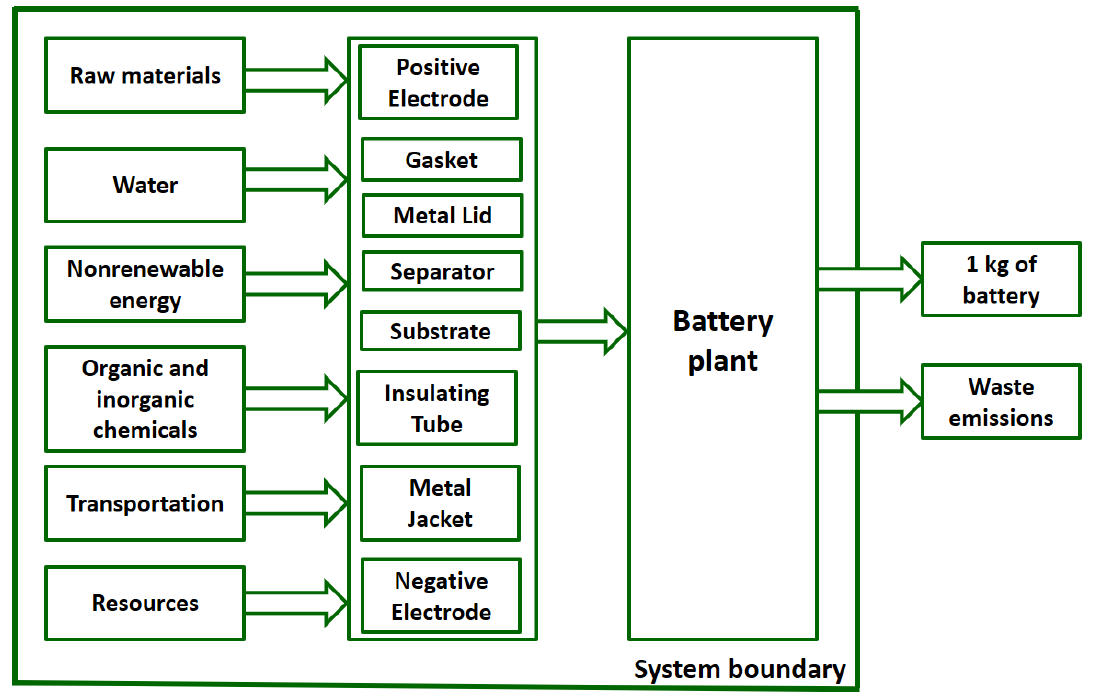
Figure 6. System boundary of the batteries for life cycle impact